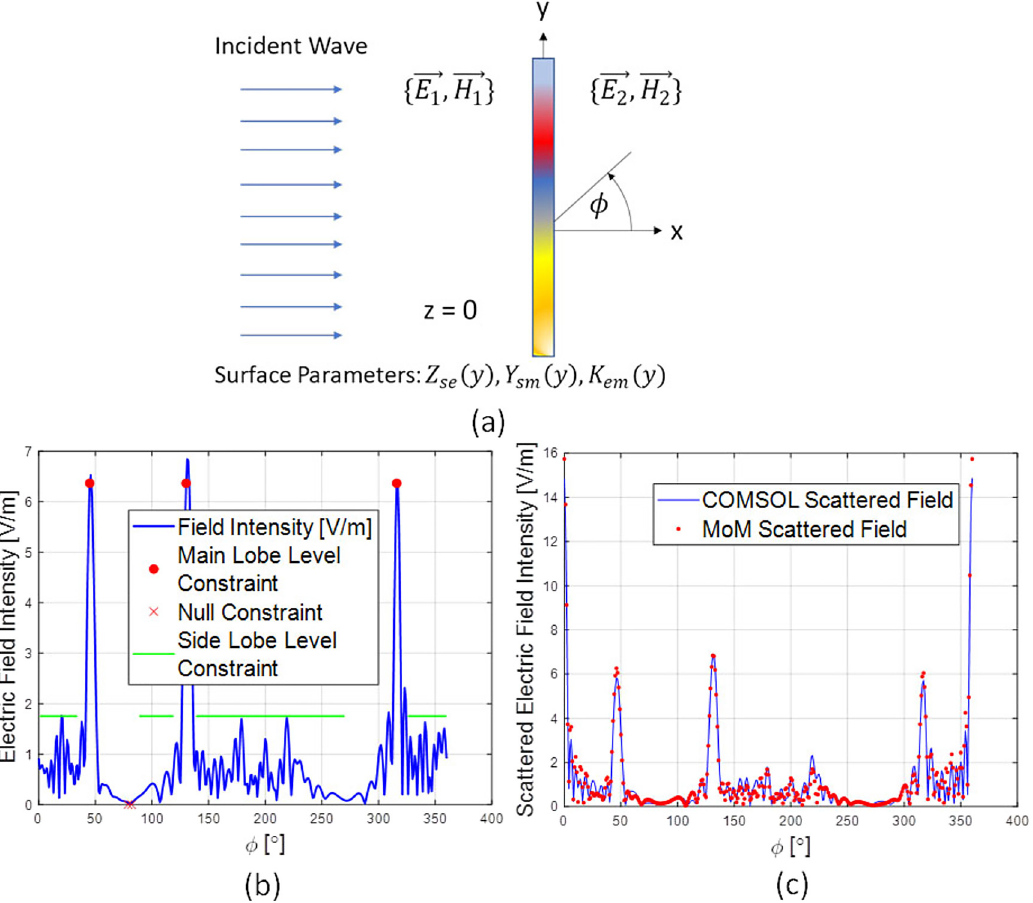
Figure 24: (Reprinted with permission from Ref. [34]). (a) Depiction of a general electromagnetic metasurface (EMMS). Fields on each side of theEMMS( E 1 , H 1 and E 2 , H 2 )induceelectricandmagneticsurfacecurrents( J s , M s )accordingtothesurfaceparameters( Z se , Y sm , K em , and K me ). (b) Multi-criteria optimization of far- fi eld parameters with an omega-type bianisotropic EMMS. (c) Scattered electric fi eld intensities com- parison for multi-criteria optimization results with COMSOL and MATLAB-based MoM